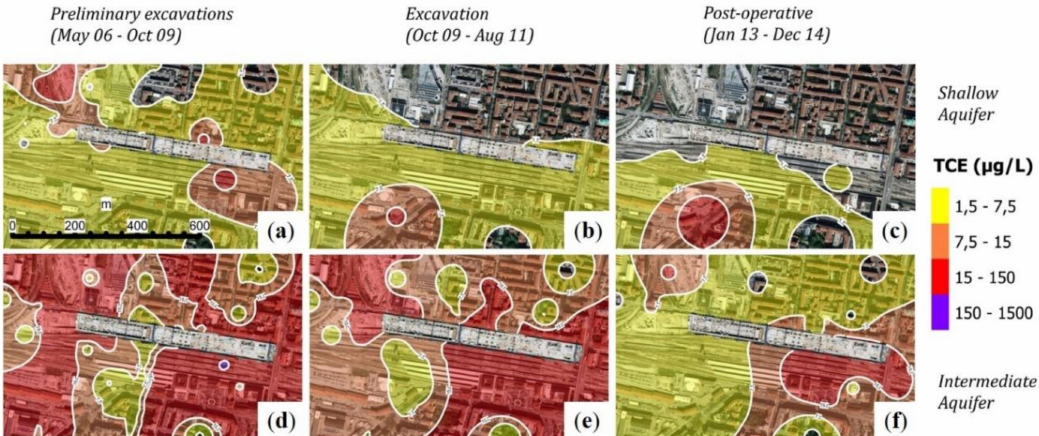
Figure 7. Contour maps representing values of trichloroethylene (TCE) concentration in ( a–c ) shallow and ( d–f ) intermediate aquifers at three time